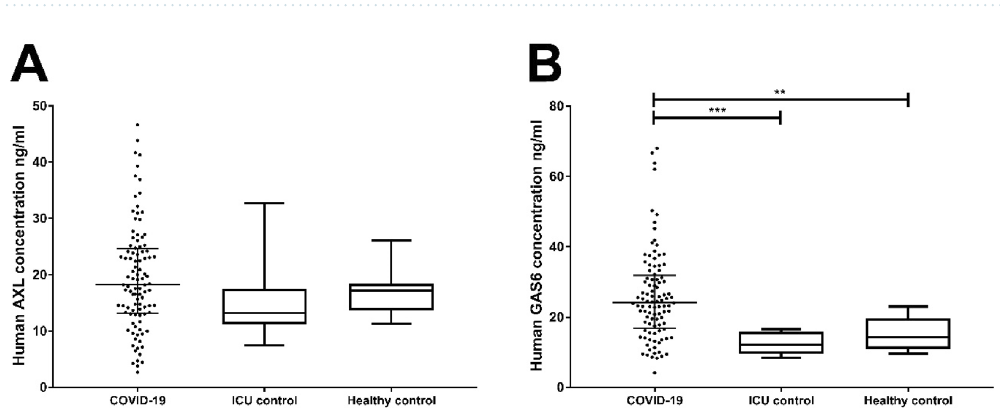
Figure 2. Detection of plasma markers GAS6 and sAXL. Plasma from COVID-19 IC patients (n = 100), non- COVID-19 IC patients (n = 11), and healthy controls (n = 15) was tested for the presence of GAS6 ( A ), and sAXL ( B ) at ICU admission. P-values were calculated with the Kruskal–Wallis test with Dunn’s post-hoc test. P-value were considered significant if p < 0.05; * 0.05, ** 0.01, *** 0.001. Statistical analysis of the three groups were p < 0.001 for Gas6 ( A ), and p = 0.134 for sAXL ( B